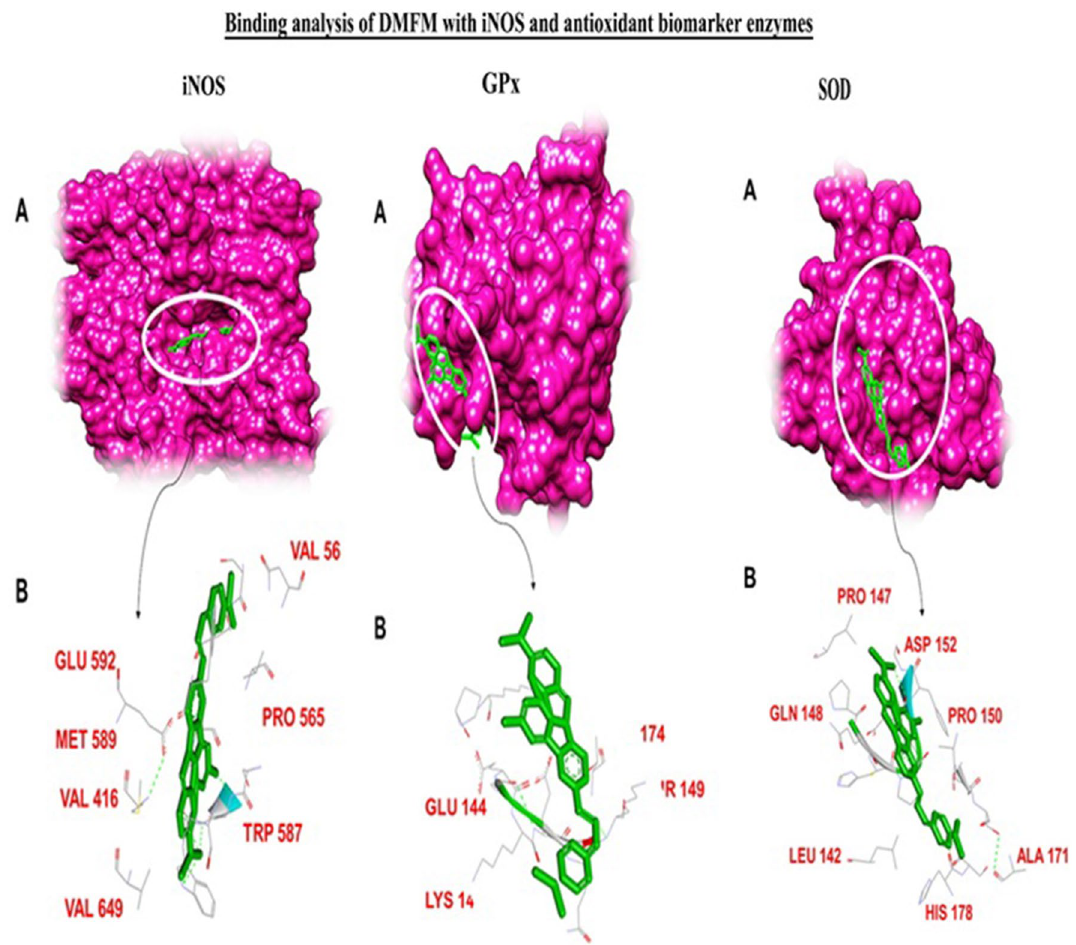
Figure 11. Binding analysis of DMFM with iNOS, GPx, and SOD protein. ( A ) In the 3D conformation, protein is shown in purple font while the DMFM is shown in the green model. ( B ) In 2D representation green stick model represent the DMFM, all the binding residues are shown in the gray line model while the green dotted lines represent